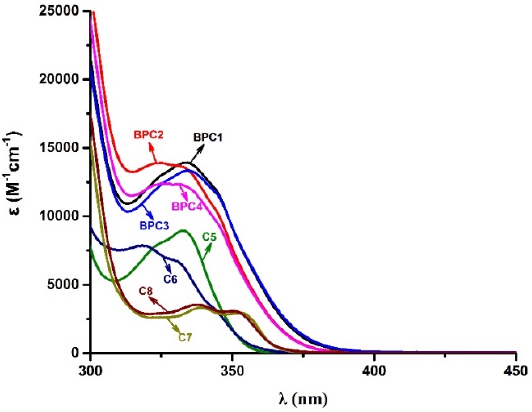
Figure 1. UV-visible absorption spectra of the carbazole derivatives in acetonitrile. Table 1. Light absorption properties of the carbazole derivatives.